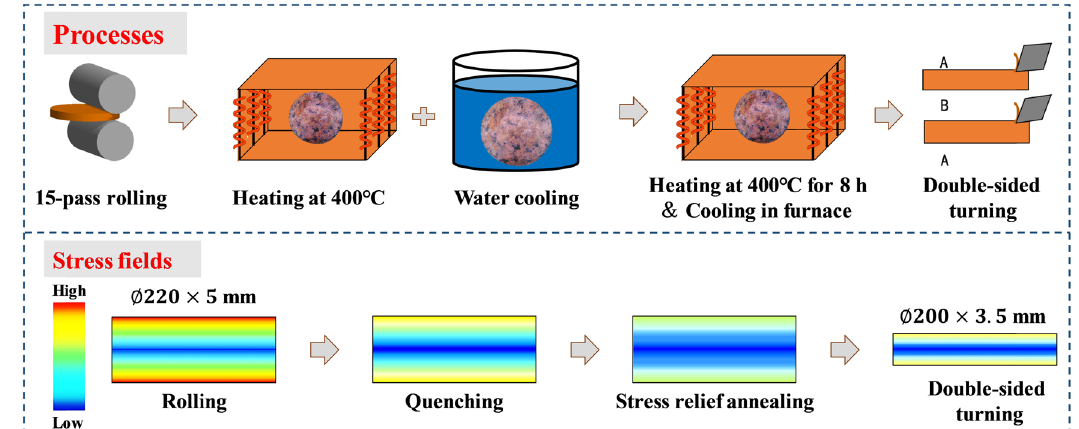
Figure 1: Schematic of symmetrical stress control